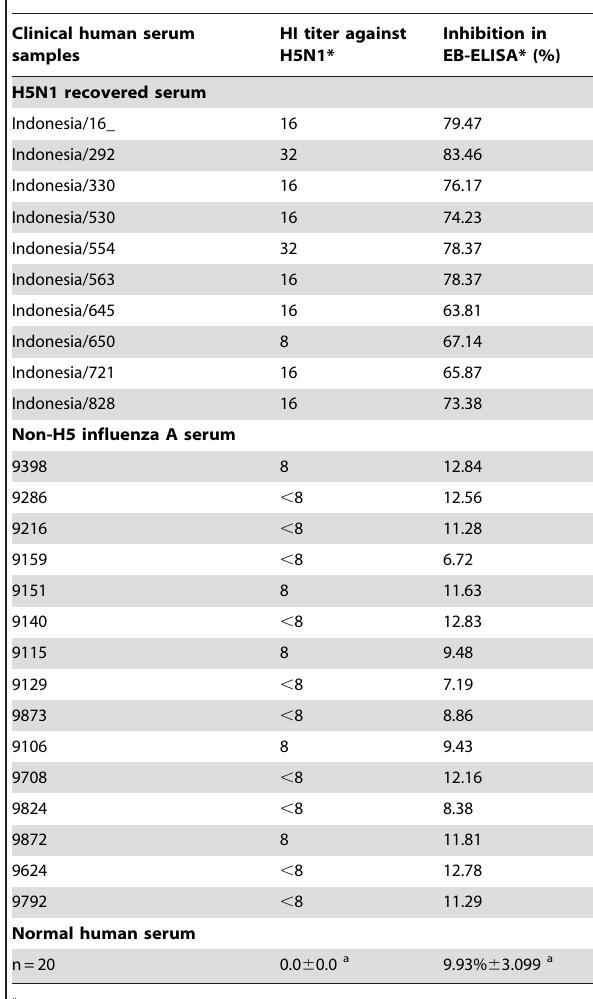
Table 5. Analysis of human serum samples in EB-ELISA.